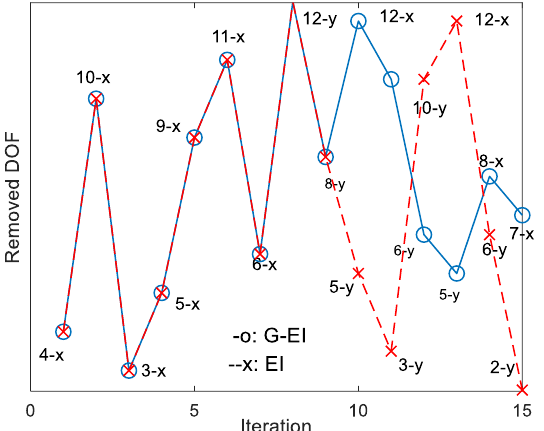
Figure 2. Transition of removed DOFs according to the iteration. The number indicates the node number, and the letters x and y indicate the measurement direction. The blue solid line indicates the G‑EI and the red dotted line the